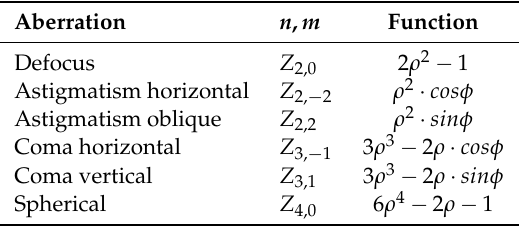
Table 1. Zernike polynomials with each mode representing type of aberration that is described by a polynomial. All polynomials depend on two parameters, azimuthal angle φ and radial distance ρ